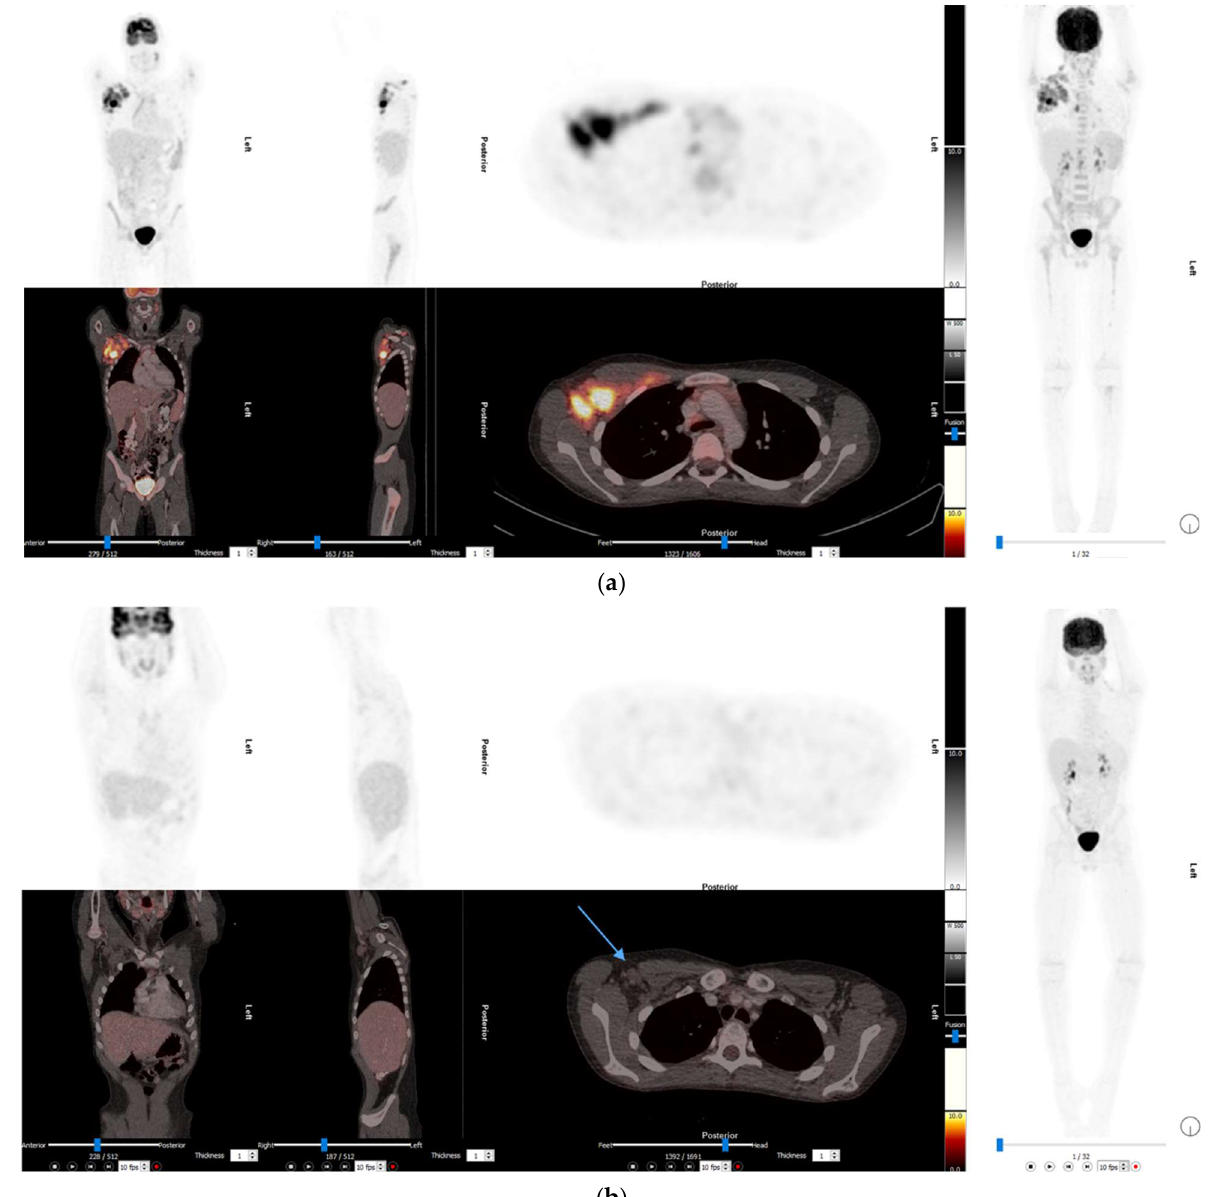
Figure 1. ( a ) The baseline 2-[ 18 F]FDG PET/CT images of a 13-year-old boy with mixed cellularity HL, there is extensive abnormal uptake in a bulky right axillary lymph node mass, hilar and sub carinal nodes, subdiaphragmatic para-aortic nodes as well as extensive bone marrow involvement. Stage 4 disease. ( b ) The interim 2-[ 18 F]FDG PET/CT performed after 2 cycles of induction chemotherapy. Nodes in the right axilla is smaller than before but, still enlarged. Uptake in these nodes is less than liver (Deauville score = 2); this is a complete metabolic response.